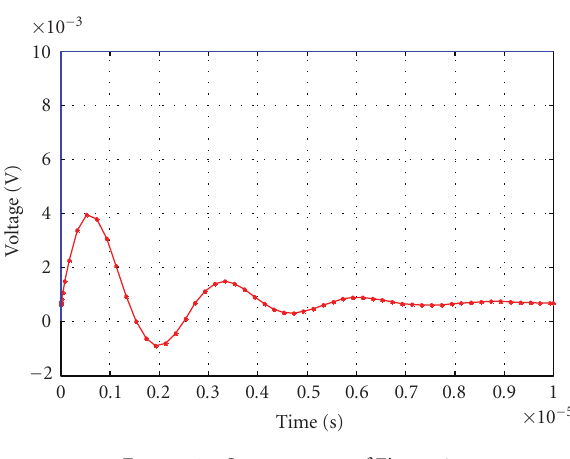
Figure 15: Step response of Figure 6.